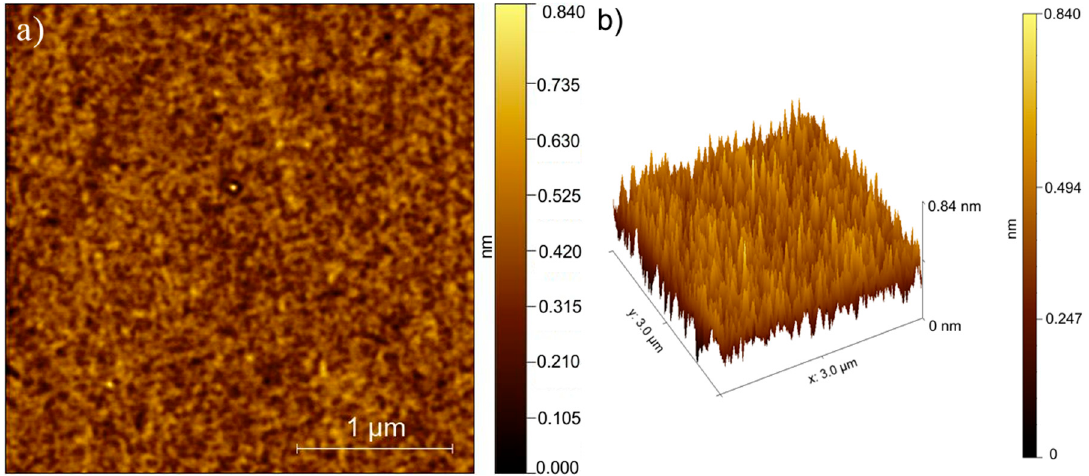
Figure 9. AFM topography image of the 5Ce-HAp coatings’ surface presented in 2D ( a ) and 3D representation of the surface topography of the 5Ce-HAp coatings ( b ).